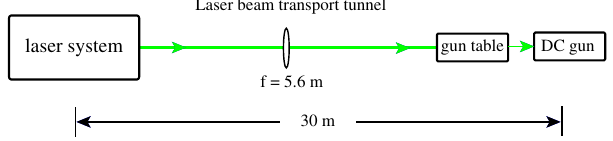
FIG. 15. The laser beam transport system. Highly reflective mirrors, a telescope and rigid mounts are used to transport optical pulses from the laser room to the optical table near the DC